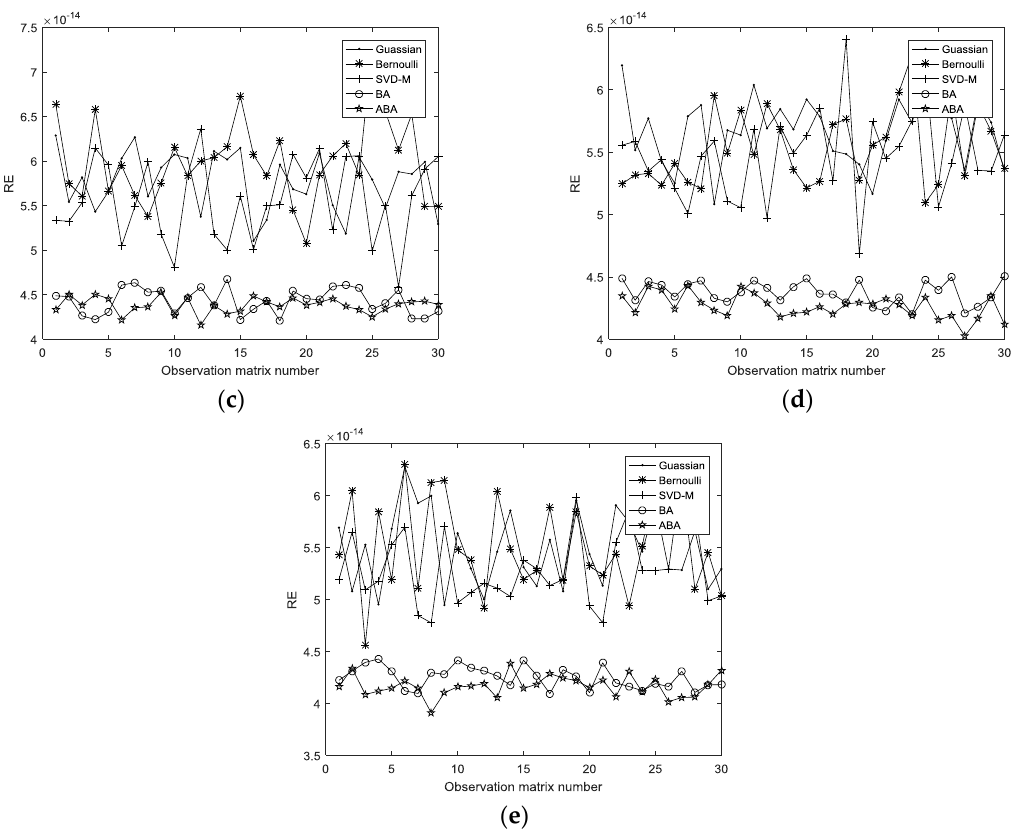
Figure 6. Reconstruction error of each algorithm to signal-3 with different compression ratio: ( a ) Rate = 0.3; ( b ) Rate = 0.35; ( c ) Rate = 0.4; ( d ) Rate = 0.45; ( e ) Rate = 0.5.